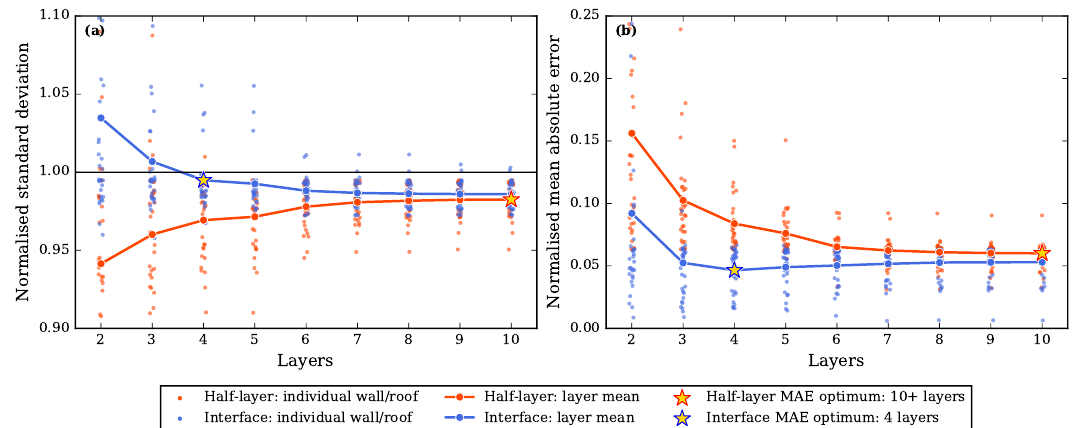
Figure 2. Heat storage errors of the half-layer and the proposed interface schemes vs. exact solutions over various levels of complexity. Thirty-two roof and wall types from the CLMU database (Jackson et al., 2010) were modelled with nine levels of complexity, for a total of 288 representations (dots). Mean of layer errors indicate scheme performance at different levels of complexity (lines). For both (a) normalised standard deviation and (b) normalised mean absolute error, the interface scheme on average outperforms the half-layer scheme. Mean improvement diminishes as the number of represented layers increases.